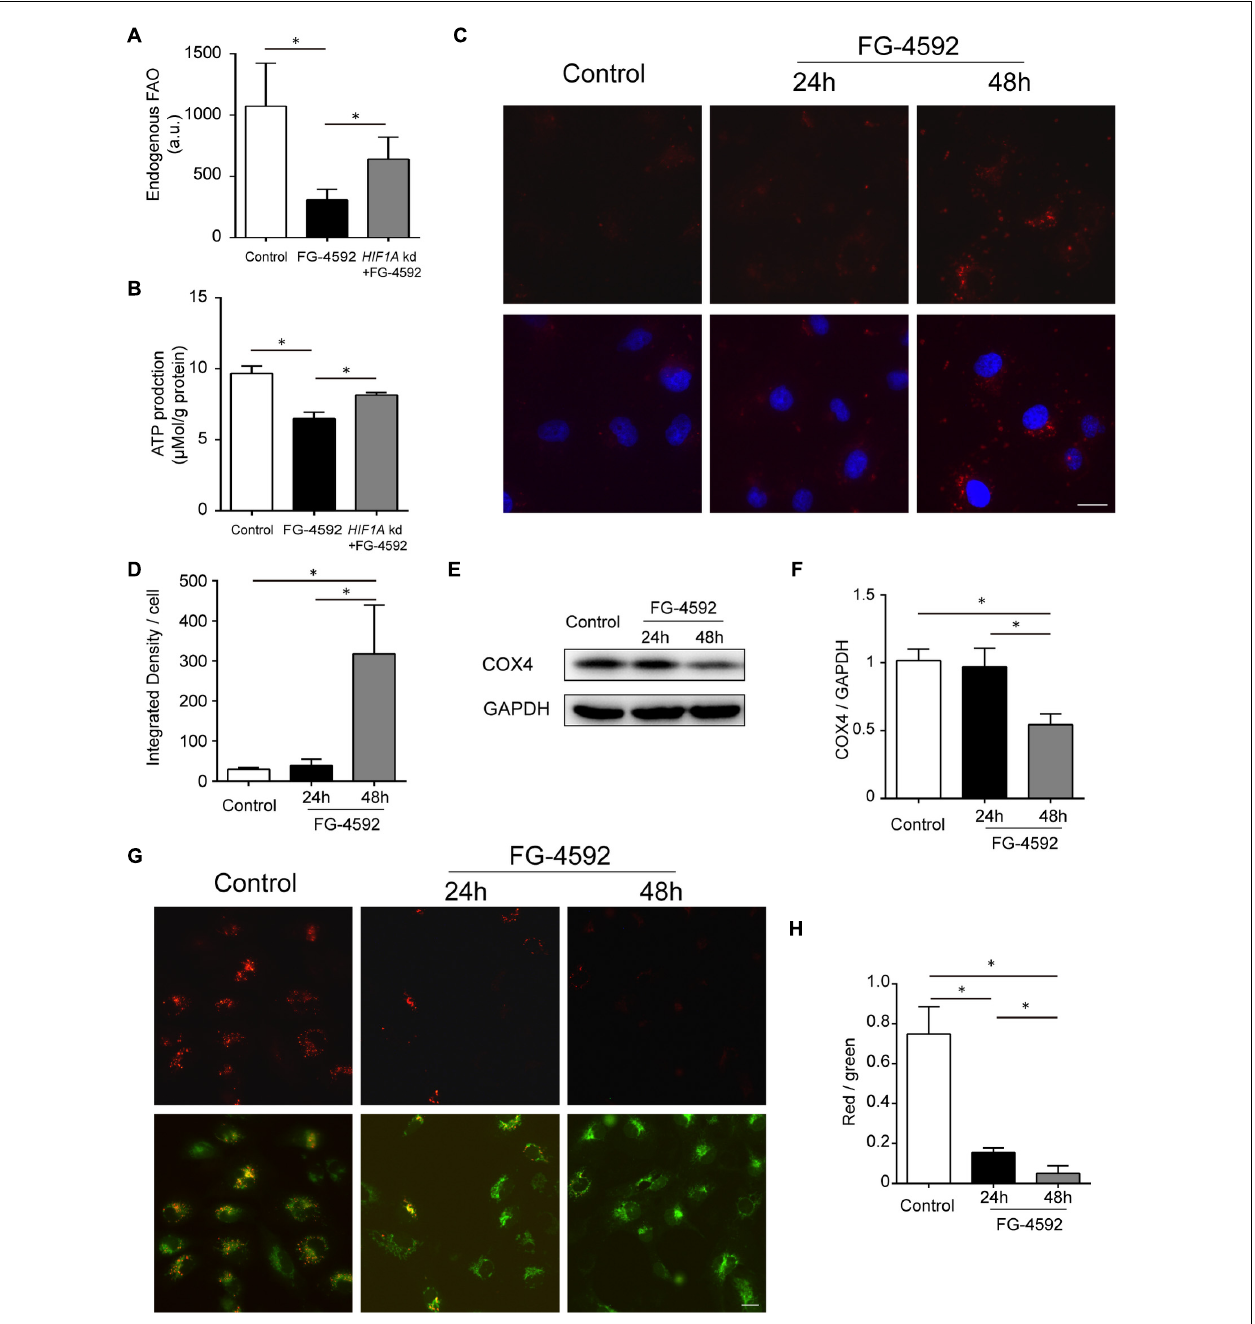
FIGURE 4 | HIF1 activation decreased FA β -oxidation. (A,B) Endogenous FAO activity assay and ATP production assay of HK2 cells cultured with or without 24 h treatment of FG-4592 (50 µ M). HIF1A kd: Cells with HIF1A siRNA knockdown before treatment. (C,D) Assessment of mitophagy in HK2 cells with a mitophagy detection reagent. The fluorescence intensity of the dye (red) was quantified. Nuclei were stained with Hoechst 33258 (blue). (E,F) Representative immunoblots and semi-quantification of COX4 in total cell lysates from HK2 cells. GAPDH was used as loading control. (G,H) Mitochondrial membrane potential ( (cid:49) ψ m) changes were detected by JC-10 staining and captured by fluorescence microscopy. Then, the red-to-green fluorescence ratio was used to quantify mitochondrial potential. Scale bars: 20 µ m. Values are expressed as the mean ± SEM (* p < 0.05).